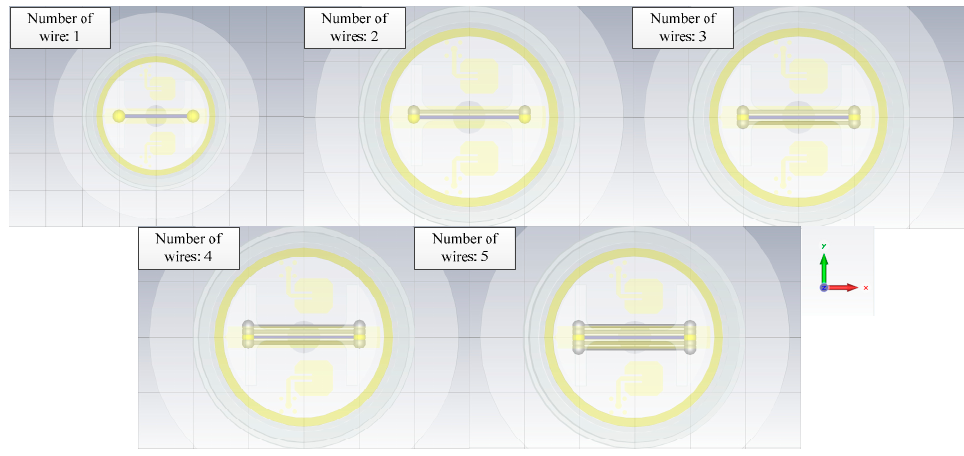
Figure 19. The geometry of the